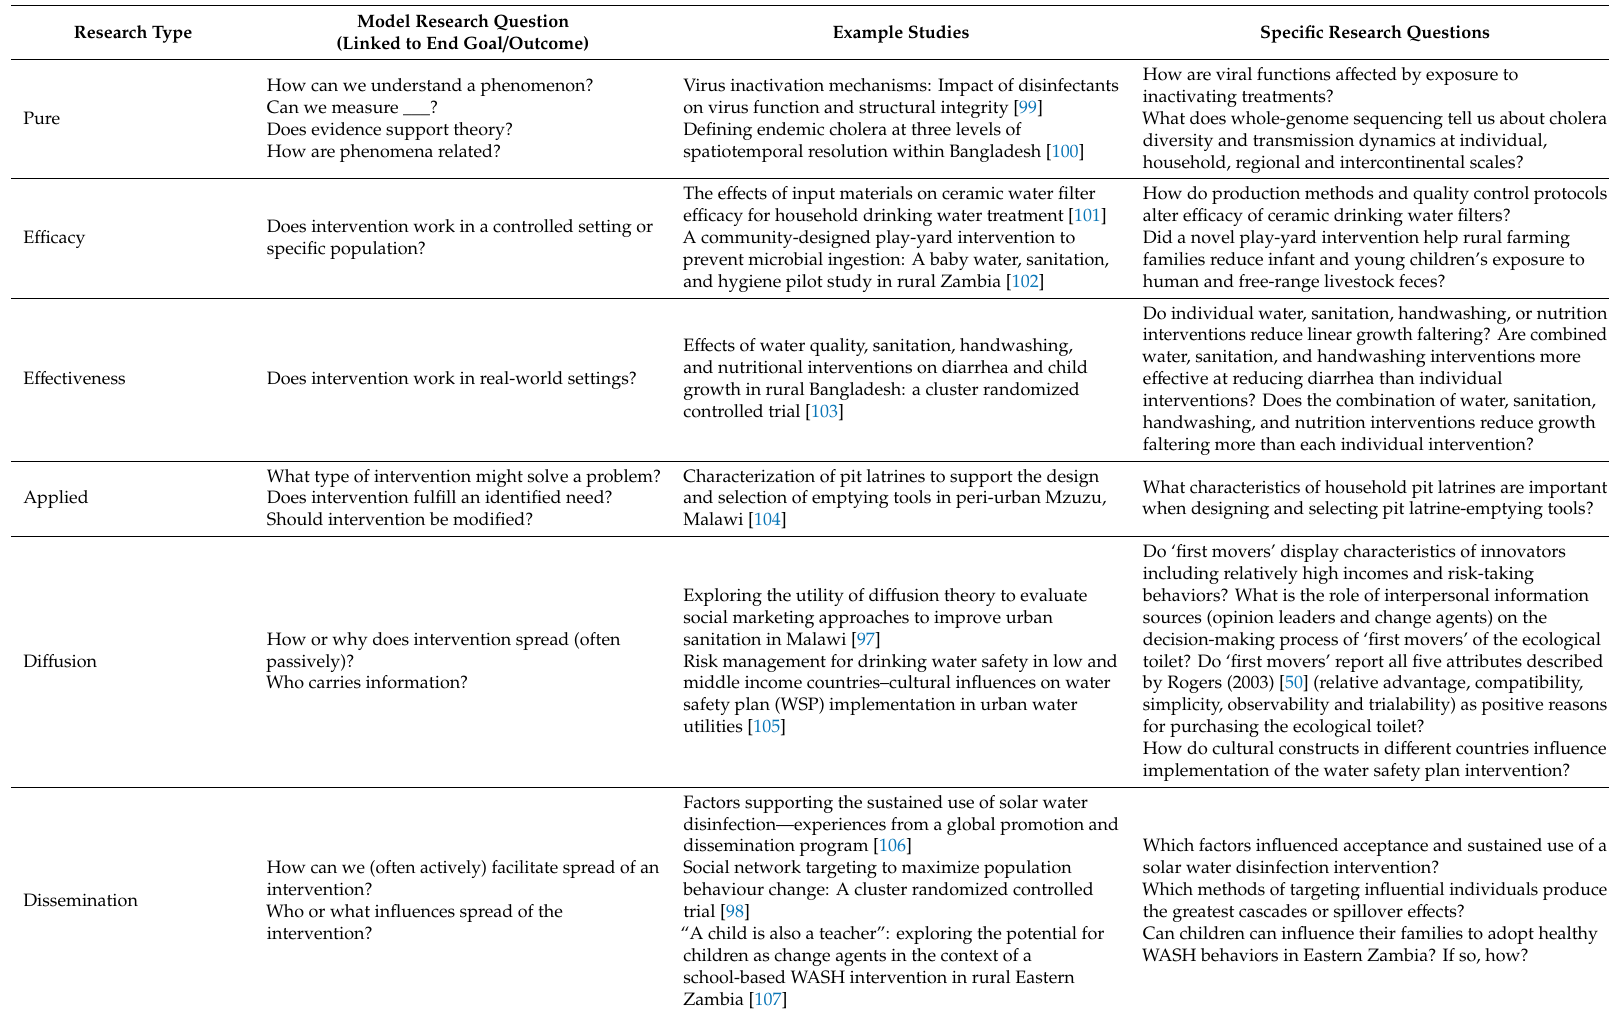
Table 3. Examples of water, sanitation, and hygiene studies addressing various translational research types and questions 1